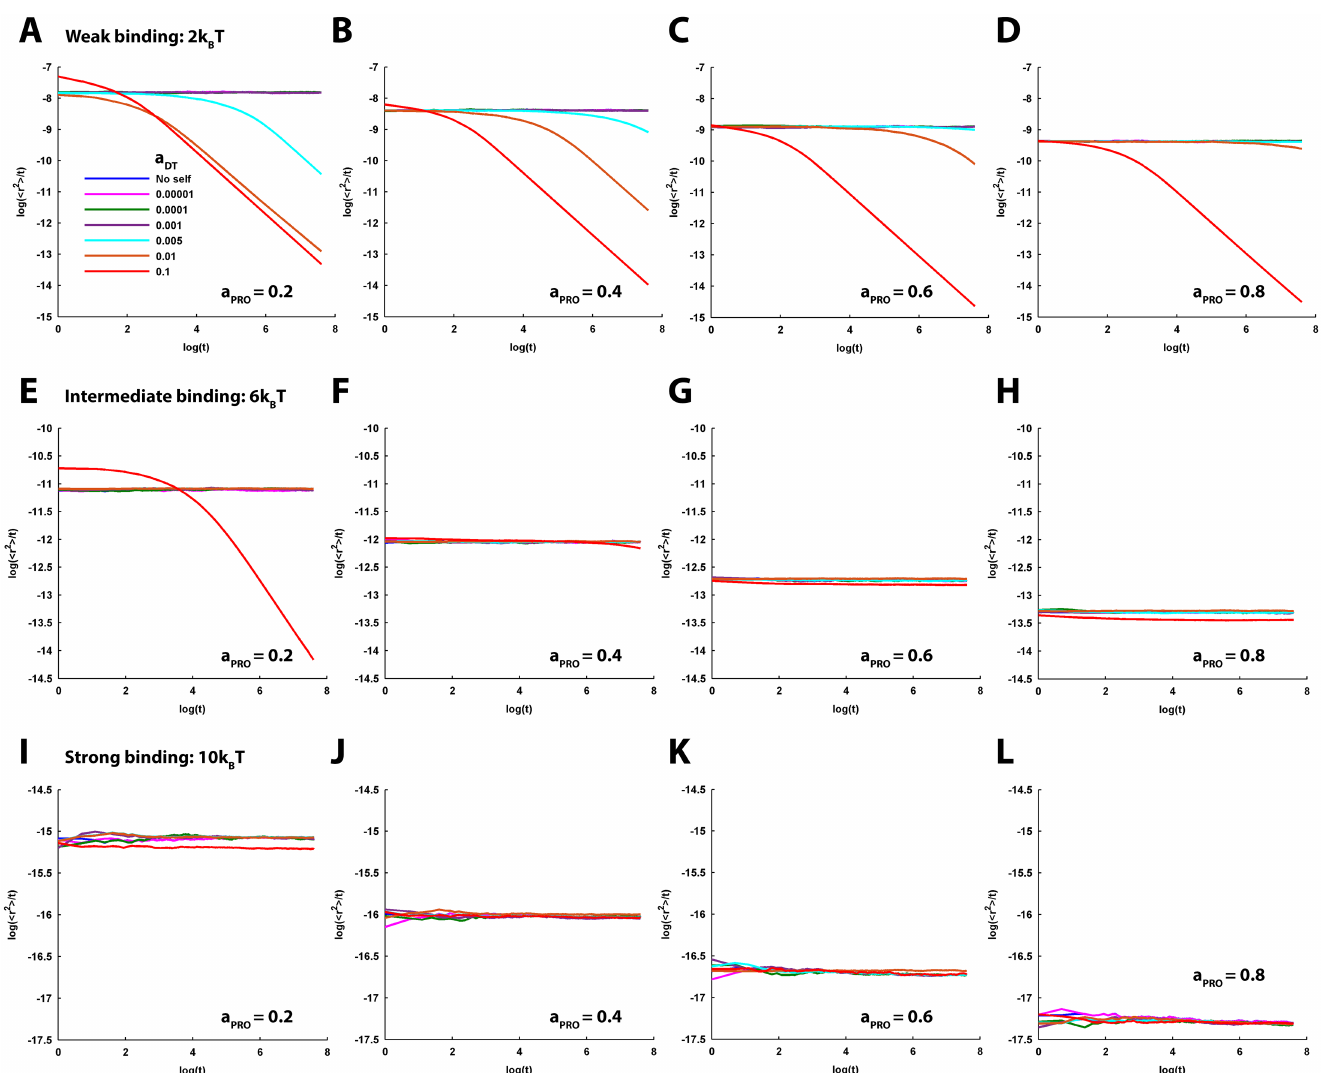
Fig 6. Log-log profiles of the MSD of tracer diffusion for the varying DT-PRO binding energy and PRO density under different self-crowding conditions. Three levels of DT-PRO binding energy, 2, 6 and 10 k B T , are considered to represent the situations of weak, intermediate and strong DT-PRO binding, respectively. Four increasing PRO densities viz. a = 0.2, 0.4, 0.6 and 0.8 are sampled to account for a range of sparse to dense submembranous crowding of PROs at the PSD. PRO Subsequently, these combinations are examined for the different conditions of self-crowding. Here, the log-log profiles under the different conditions of self-crowding are laid together in a single plot. (A-D) Weak -PRO binding. The profiles for no-self-crowding condition and a (cid:20) 0.001 are consistently flat (representing perfectly DT normal diffusion) regardless of the a PRO as well as fairly overlap with each other. For a DT (cid:21) 0.005, the profiles indicate strong anomalous diffusion for the lower a PRO = 0.2. Increase in a PRO causes a gradual transition of the profiles from strongly anomalous to normal diffusion, though the intensity of the anomalousity relaxation further depends on the level of a . For example, the profile for a = 0.005 acquires perfectly normal behaviour by a = 0.8 and overlaps with that of the lower a . DT DT PRO DT However, the profile for a DT = 0.01 carries slightly anomalous behaviour even at a PRO = 0.8. The anomalousity in the profile for a DT = 0.01 remains insignificantly affected by the increase in a . (E-H) Intermediate DT-PRO binding. The profiles for the no-self-crowding condition and a (cid:20) 0.01 consistently exhibit normal PRO DT diffusion regardless of a PRO and fairly overlap with each other. Notably, a DT = 0.1 is associated with strongly anomalous behavior for the lower a PRO = 0.2. However, the anomalousity steeply decreases with the increase in a and the log-log profile approaches closer to that for the a (cid:20) 0.01. (I-L) Strong DT-PRO binding. The PRO DT profiles for the no-self-crowding condition and all values of a DT consistently exhibit normal diffusion regardless of the a PRO and remain sufficiently overlapping with each other. (A-L) Altogether, increase in binding ameliorates anomalousity of tracer diffusion arising from their higher self-crowding. Furthermore, increase in a PRO and binding energy cause the log-log profiles to shift to lower levels. In general, this has implications to the decrease in tracer mobility in terms of the effective diffusion coefficient.